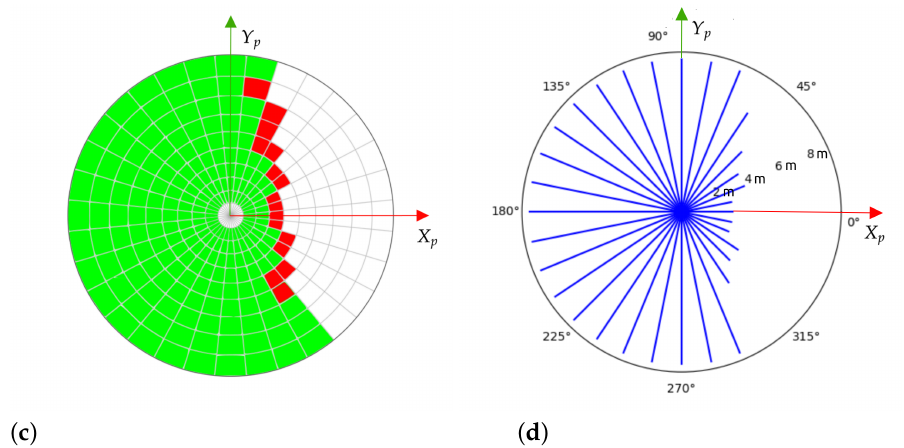
Figure 5. Visualization of a single vertical 2D scan from the simulated 3D LiDAR of Andabata ( a ), a 3D point cloud ( b ), the deduced cell traversability ( c ) and the virtual 2D traversability ranges ( d ).